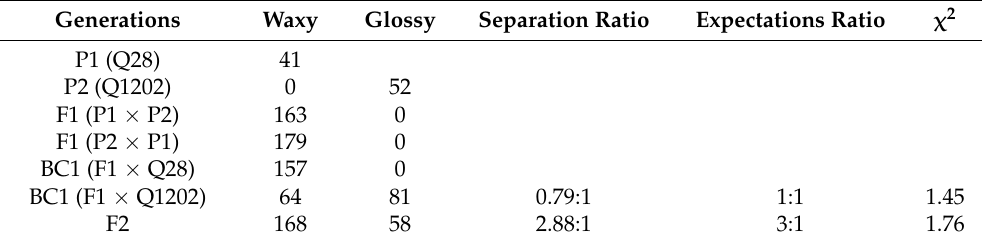
Figure 2. Scanning electron micrographs of Q1202 and Q28 at the rosette ( A ) and shoot stages ( B ). Table 1. Genetic analysis of waxy characters in parents and generations of nonheading Chinese cabbage.